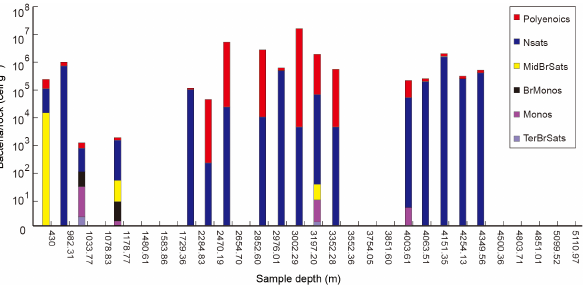
Figure 7. Bacteria and Archaea species from core samples of the